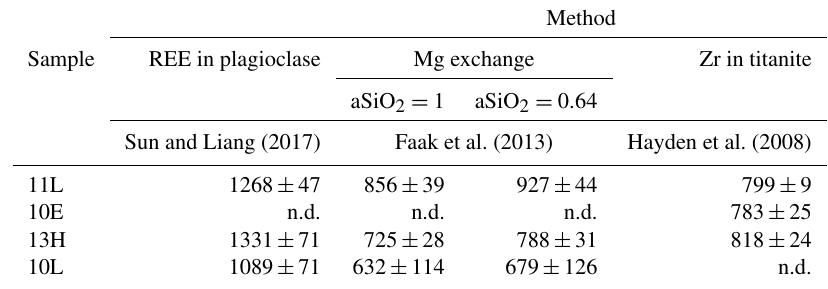
Table 6. Summary of mineral thermometry results (in ◦ C).